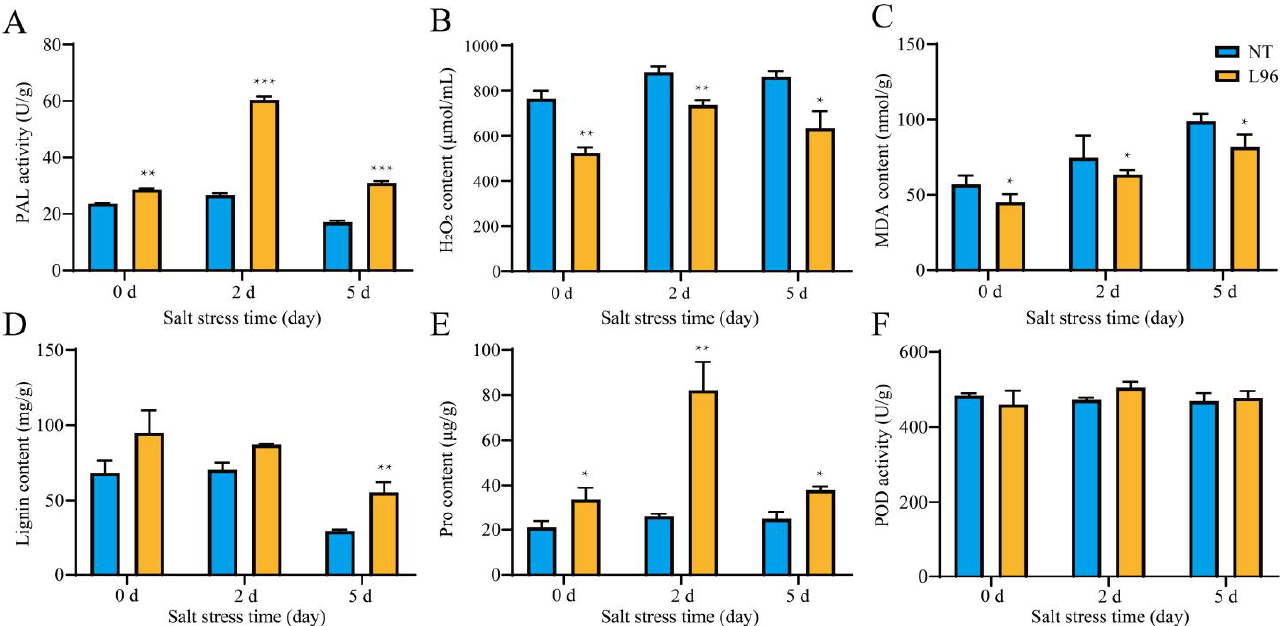
Figure 1. Physiological indices of NT and L96 plant under salt stress. Changes in the contents of ( A ) PAL, ( B ) H 2 O 2 , ( C ) MDA, ( D ) lignin, ( E ) Pro, and ( F ) POD in NT and L96 under salt stress (150 mM NaCl). Data represent the mean ± SD from three biological replicates. Significance was determined by the least significant difference, and asterisks indicate statistically significant differences from NT (* p < 0.05, ** p < 0.01, *** p < 0.001).